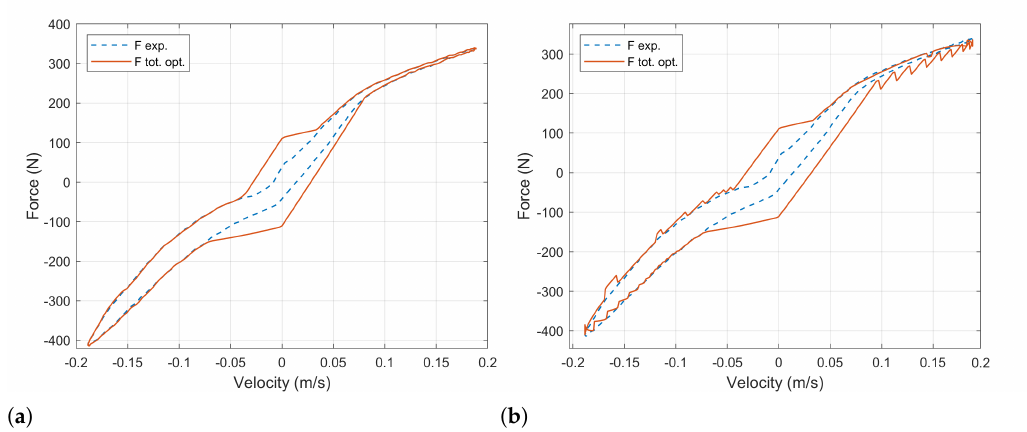
Figure 10. ( a ) Dynamic adjustment of load resistance using an analog potentiometer. ( b ) Dynamic adjustment of load resistance using a digital potentiometer with 40 values.